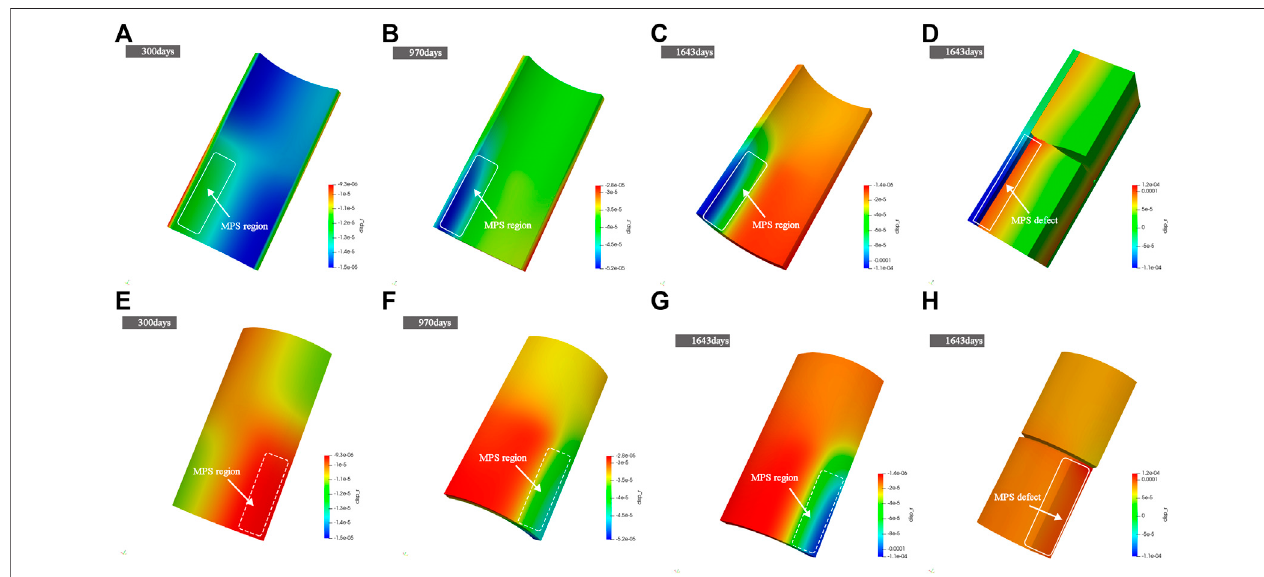
FIGURE12| Theradialdisplacementdistributiononcladdinginnersurface (A – C) ,outersurface (E – G) ,fuelrod(d)andpelletssurface(h)indifferentoperatingstage.